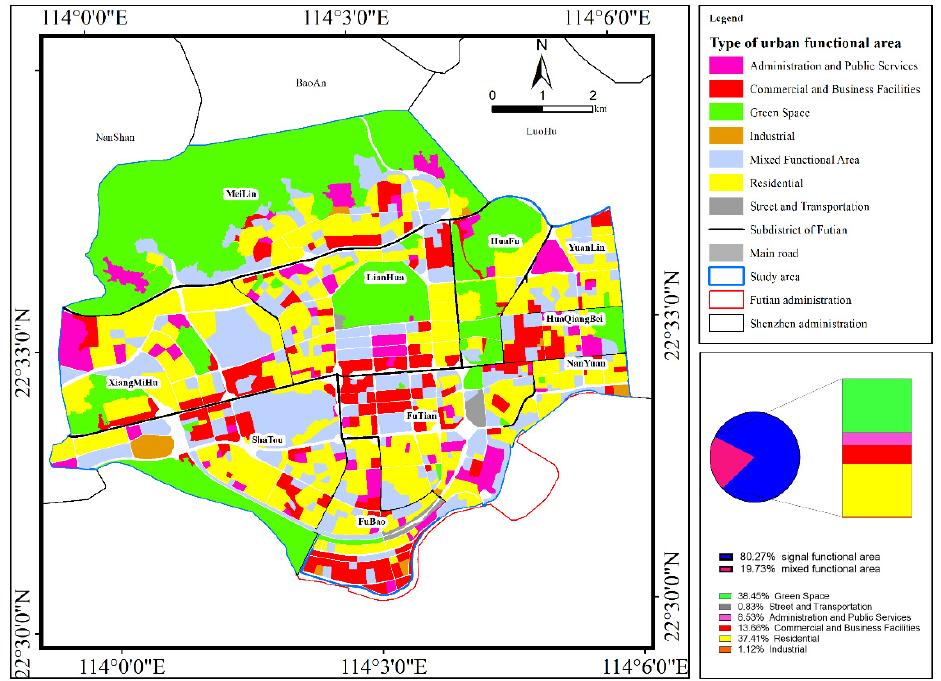
Figure 7. Result of the identification of single-function zones.